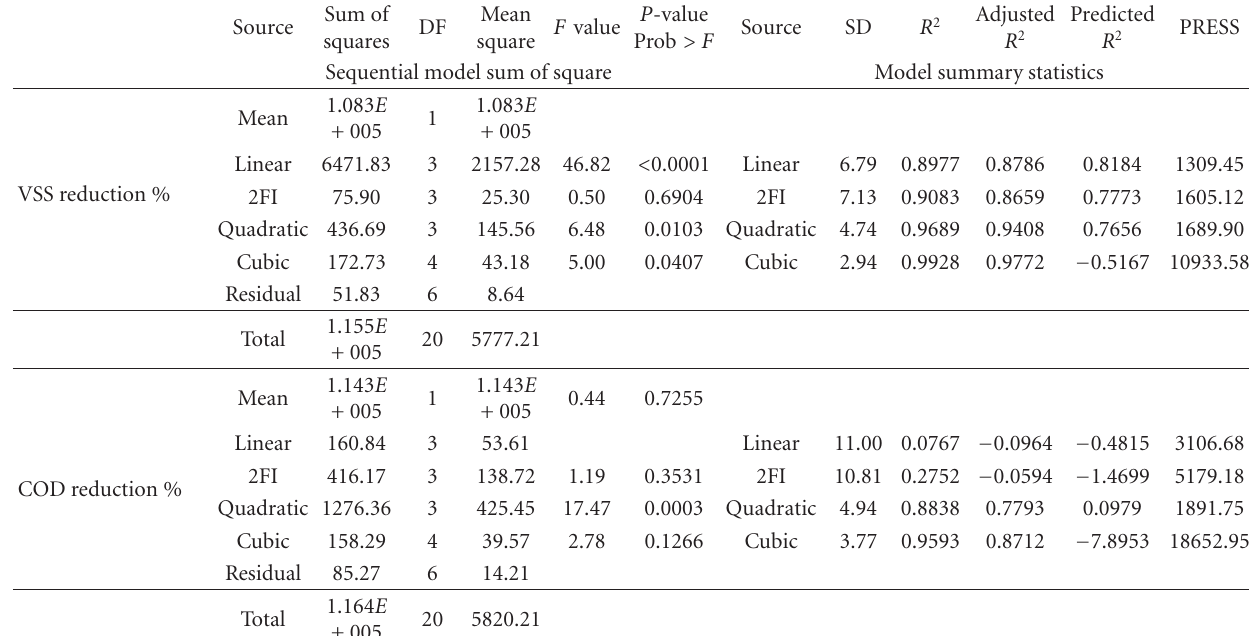
Table 4: Adequacy of the model resulted for VSS and COD reduction. Source PRESS Sequential model sum of